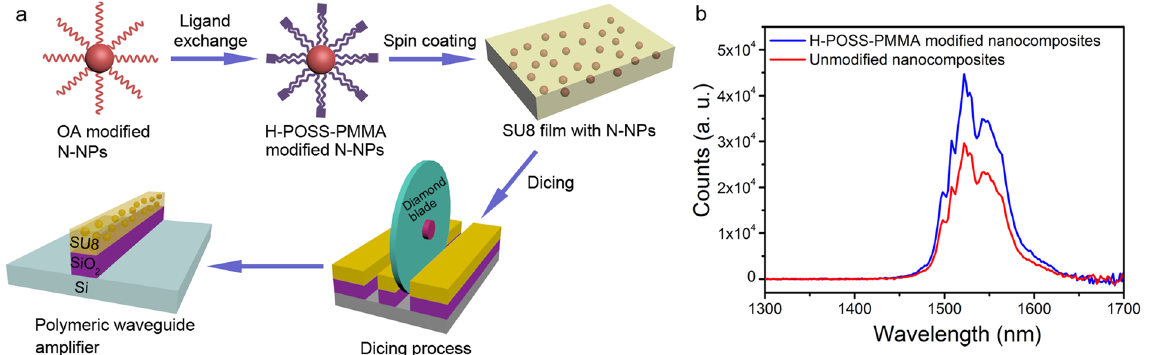
Figure 3. Fabrication and IR emissive properties of our active polymeric waveguide core. ( a ) Design and workflow for the fabrication of our polymeric waveguide amplifier. N-NPs represents NaYF 4 :Yb,Er,Ce core- shell nanoparticles; ( b ) IR emission spectra of polymer nanocomposites doped with H-POSS-PMMA modified and unmodified N-NPs. The enhanced IR emission of H-POSS-PMMA modified N-NPs nanocomposites is attributed to the decreased scattering losses due to excellent particle dispersion.